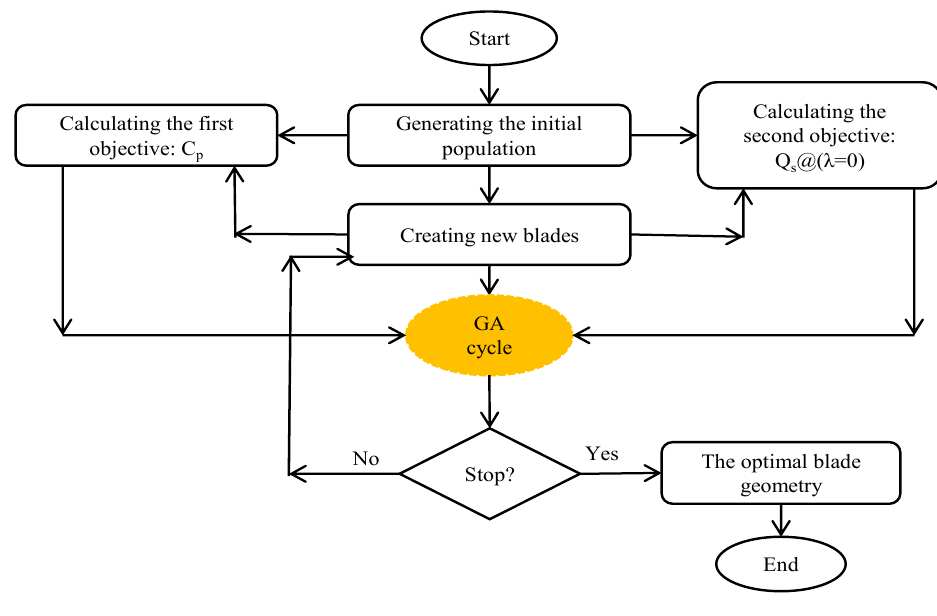
Figure 4. Flowchart of the optimization process.